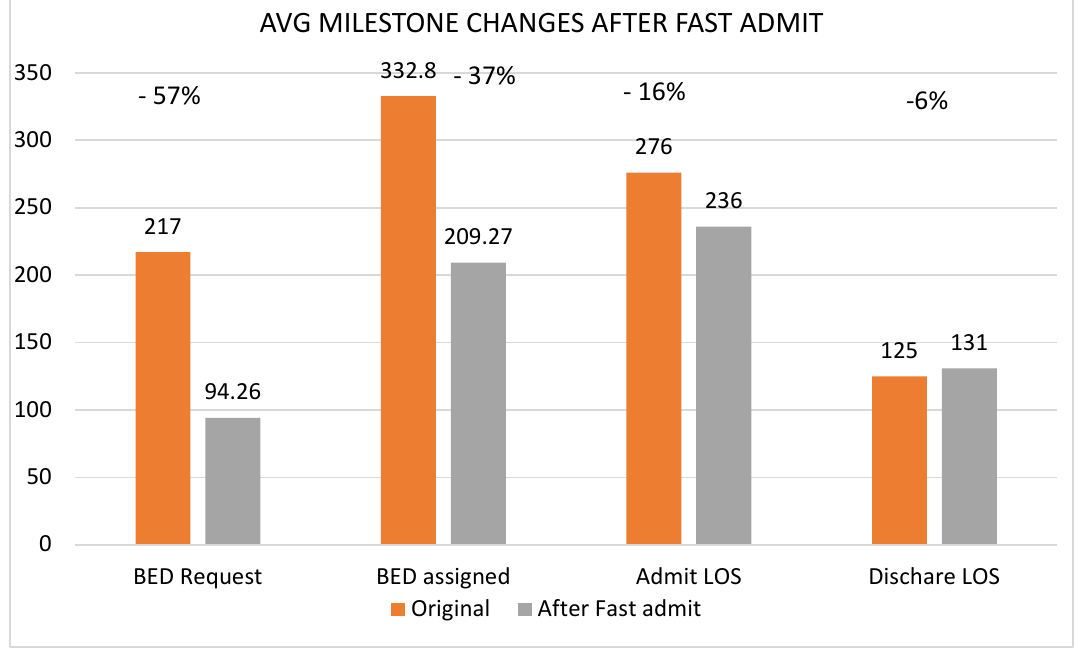
Figure 7 Average milestone changes after the rapid-admit adjustments (Image Copyright: